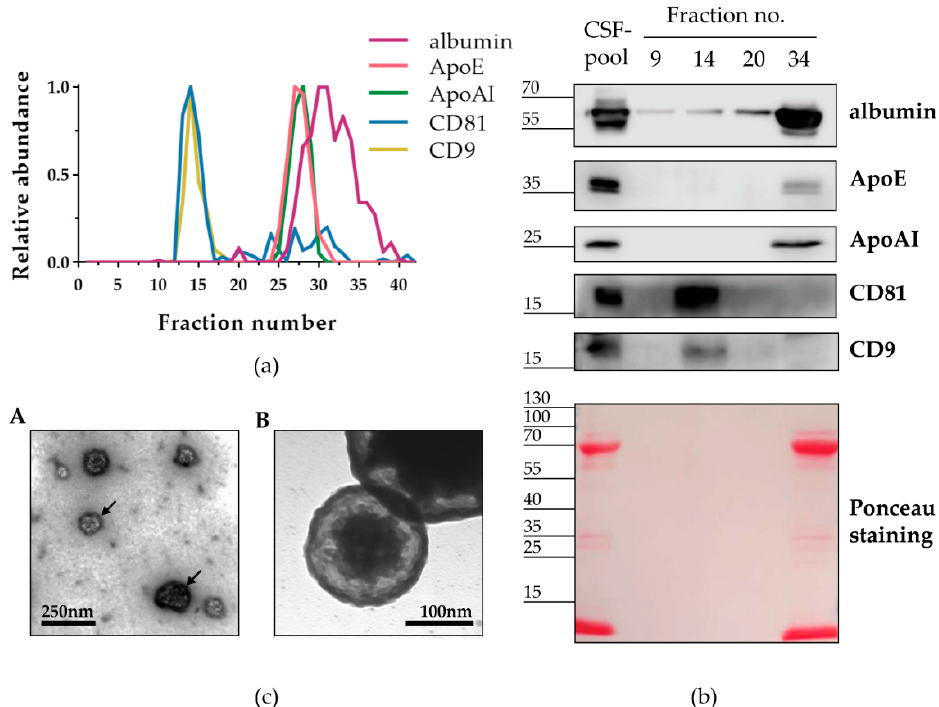
Figure 4. Nanoparticles isolated by Sepharose CL-6B contain CD9+ and CD81+ EVs. ( a ) CSF-pool from severe traumatic brain injury patients was separated by a gravity-flow column packed with sepharose CL-6B. Consecutively collected fractions indicated by numbers together with CSF-pool as positive control (PC) and PBS (mobile phase in SEC) as negative control (NC) were applied to nitrocellulose membrane by slot blot and analysed by immunodetection of indicated proteins. Shown are representative immunoblots after chemiluminescence. The chemiluminescence signal after immunodetection on slot blots for indicated proteins was quantified and normalised to the PC signal. Shown are relative protein abundances obtained by the quantification of representative immunoblots ( b ). Selected fractions were analysed by western blot after protein separation by SDS- PAGE. ( c ) Transmission electron microscopy micrograph showing round shaped extracellular vesicles measuring 100–130 nm in diameter and indicated by arrows ( A ). Higher magnification of electron micrograph showing extracellular vesicle with double-layer membrane measuring 175 nm ( B